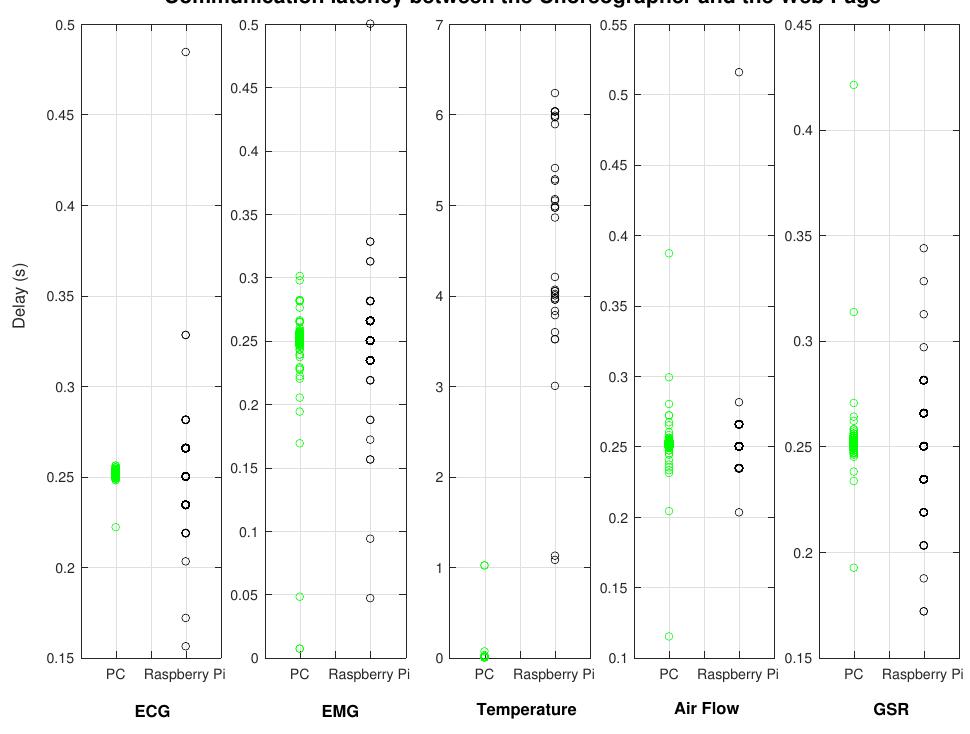
Figure 10. Comparison of the delay in the communications for the system deployed on a desktop computer and a Raspberry Pi for the segment between the Choreographer and the webpage with the active communication